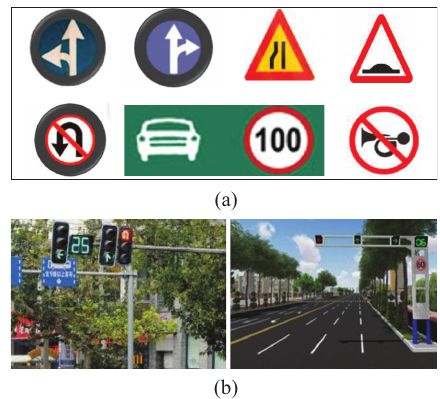
Figure 21. The examples of various traffic signs and lights: ( a ) traffic signs; ( b ) traffic